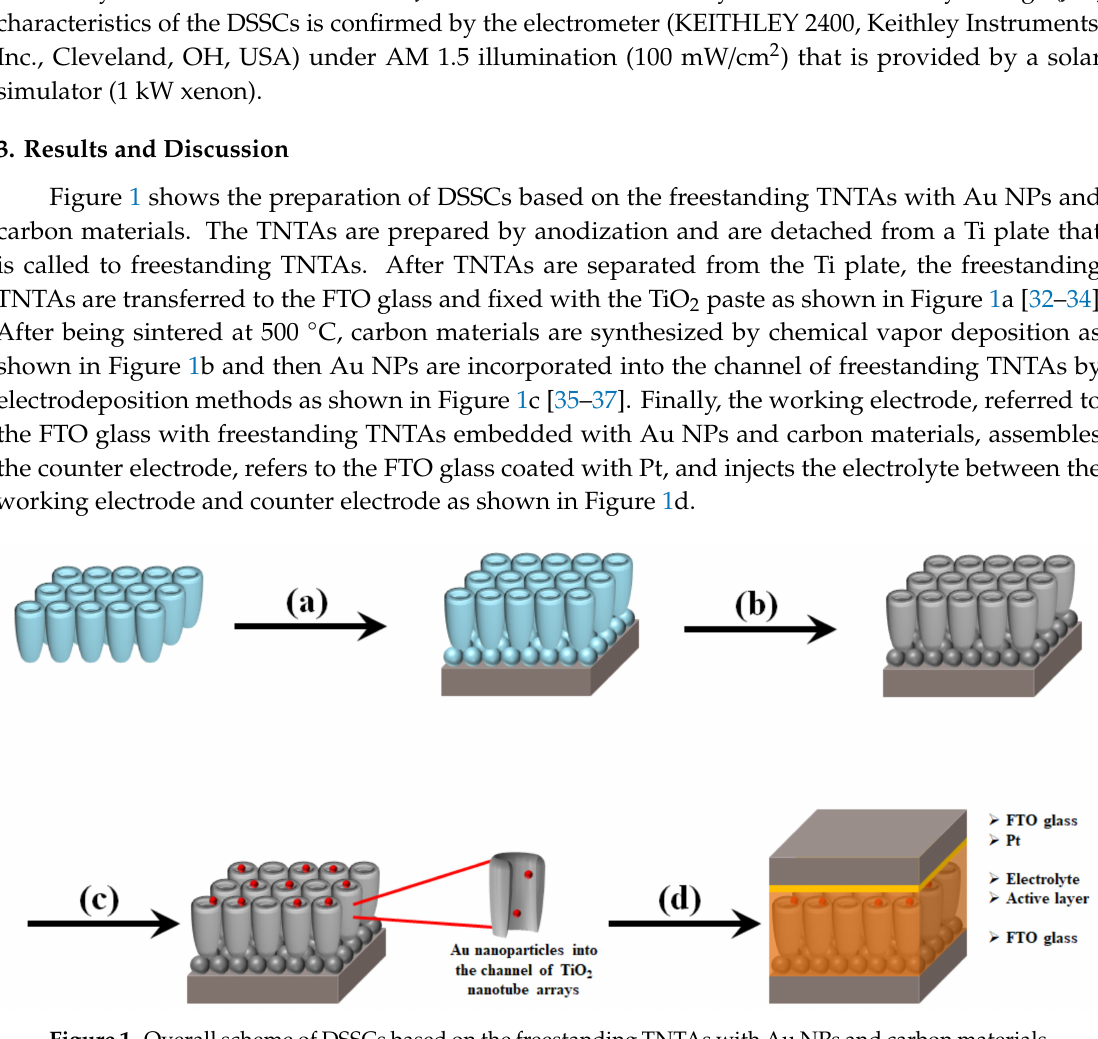
Figure 1. Overall scheme of DSSCs based on the freestanding TNTAs with Au NPs and carbon materials. ( a ) Transfer of freestanding TNTAs on the FTO glass with TiO 2 paste, ( b ) Synthesis of carbon materials on freestanding TNTAs, ( c ) preparation of Au NPs into the channel of freestanding TNTAs, and ( d ) fabrication of